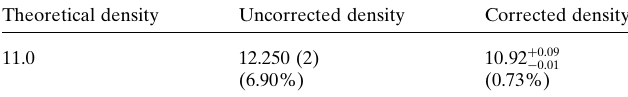
Table 1 Theoretical mean density and densities obtained by the outlined optimization procedure before and after correcting for the pink beam